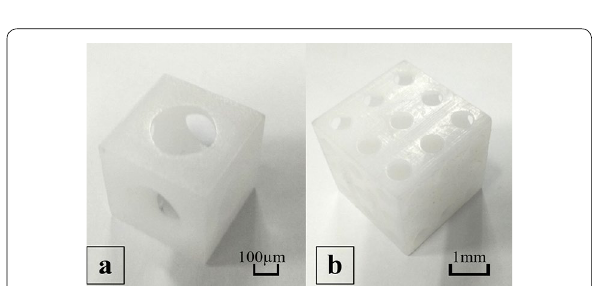
Figure 4 Bone scaffolds: a single-unit model, b 27-unit model